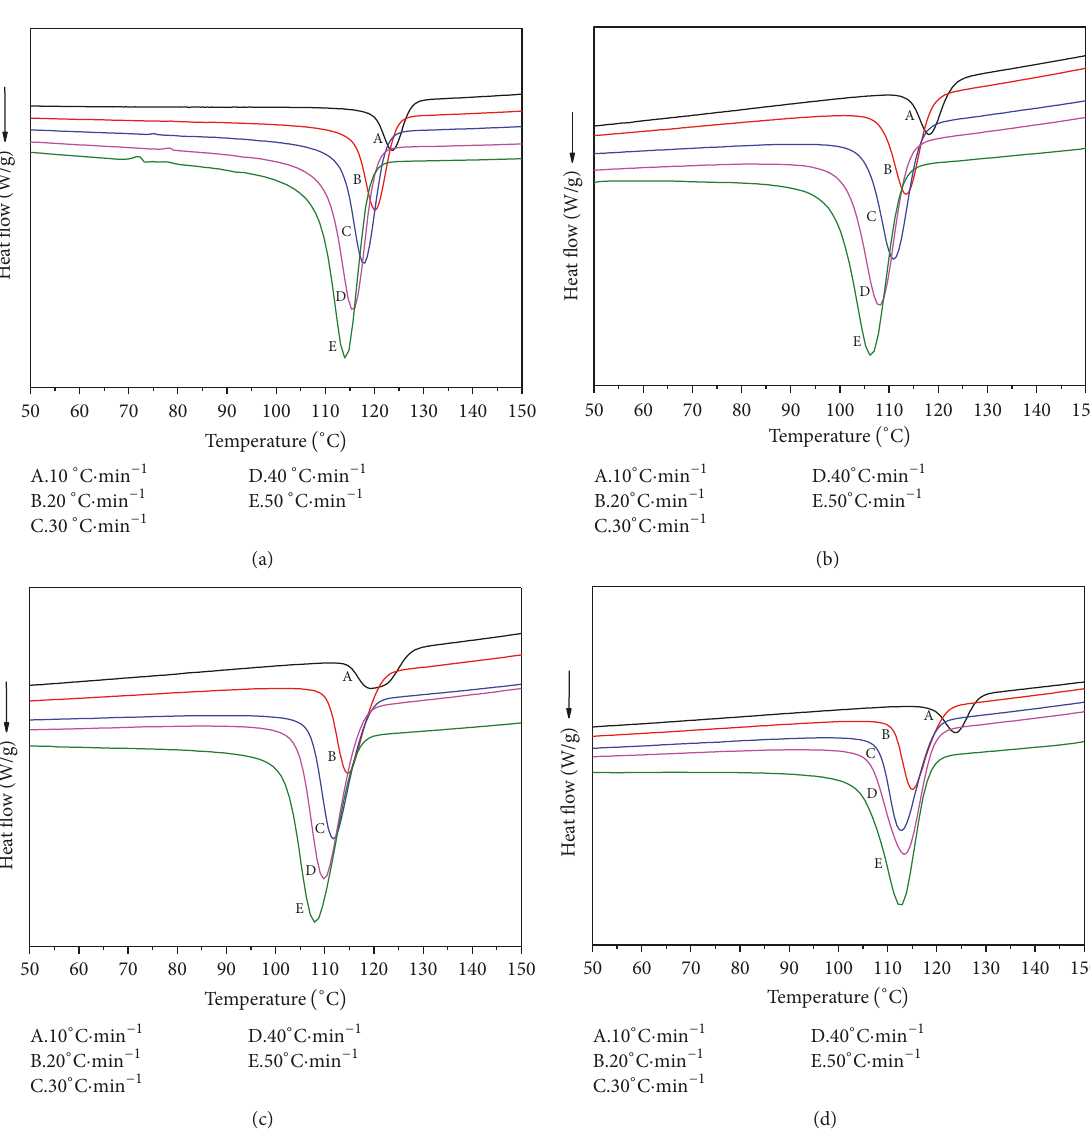
Figure 6: The curves of rPP and its composites at different cooling rates: (a) pure rPP, (b) MCC/rPP (60/40), (c) MCC/PP-g-MA/rPP (60/5/35), (d)